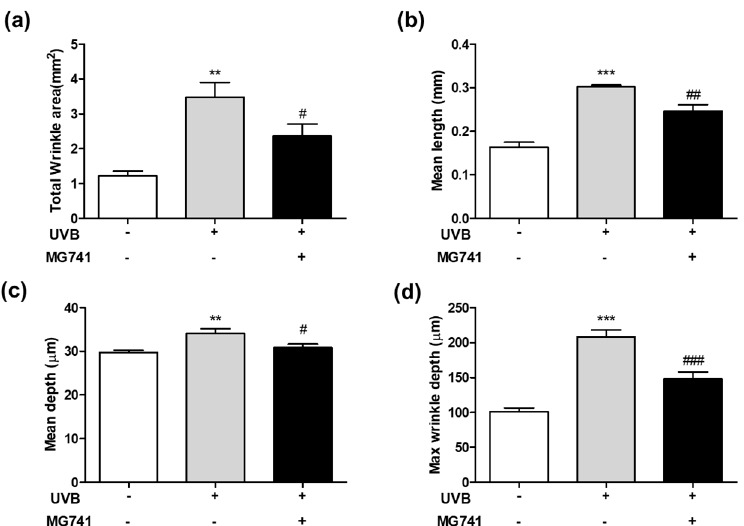
Figure 4. Effect of Bi. lactis MG741 on skin wrinkle formation such as ( a ) total wrinkle area, ( b ) mean length, ( c ) mean depth and ( d ) max wrinkle depth in UVB-exposed HR-1 mice. HR-1 mice were treated with Bi. lactis MG741 (1 × 10 9 CFU/head/day) orally and UVB irradiation on dorsal skin until 12 weeks. Data are indicated as means ± SE ( n = 6). ** p < 0.01, and *** p < 0.001 vs. no-UVB control; # p < 0.05, ## p < 0.01, and ### p < 0.001 vs. UVB-exposed control. Though H&E staining, UVB exposure in HR-1 mice resulted in marked thickening of the dorsal skin (3.39-fold of non-exposure; Figure 5a,b); however, Bi. lactis MG741 reduced the epidermal thickness up to 0.82-fold in UVB-exposed HR-1 mice. As shown in Figure 5c,d, UVB irradiation of the dorsal skin of HR-1 mice induced increase in TEWL (8.92-fold, significantly) and loss of skin hydration (0.91-fold) compared with non-exposure. Bi. lactis MG741 mitigated these changes caused by UVB (in TEWL, 0.82-fold; in loss of skin hydra- tion, 1.08-fold). Figure 5. Histological examination and skin hydration of UVB-exposed dorsal skin tissue of HR-1 mice treated with Bi. lactis MG741. The animal experiment procedure is the same as described in the legend in Figure 4. ( a ) The images of dorsal skin sections were stained by hematoxylin and eosin (H&E) using a microscope at 100× magnification. Double arrows indicate the epidermis. At 12 weeks, the dorsal skins were collected to measure ( b ) the epidermis thickness (based on H&E stain), ( c ) TEWL, and ( d ) skin hydration. Data are indicated as means ± SE ( n = 6). *** p < 0.001 vs. no-UVB control; # p < 0.05, and ### p < 0.001 vs. UVB-exposed control.